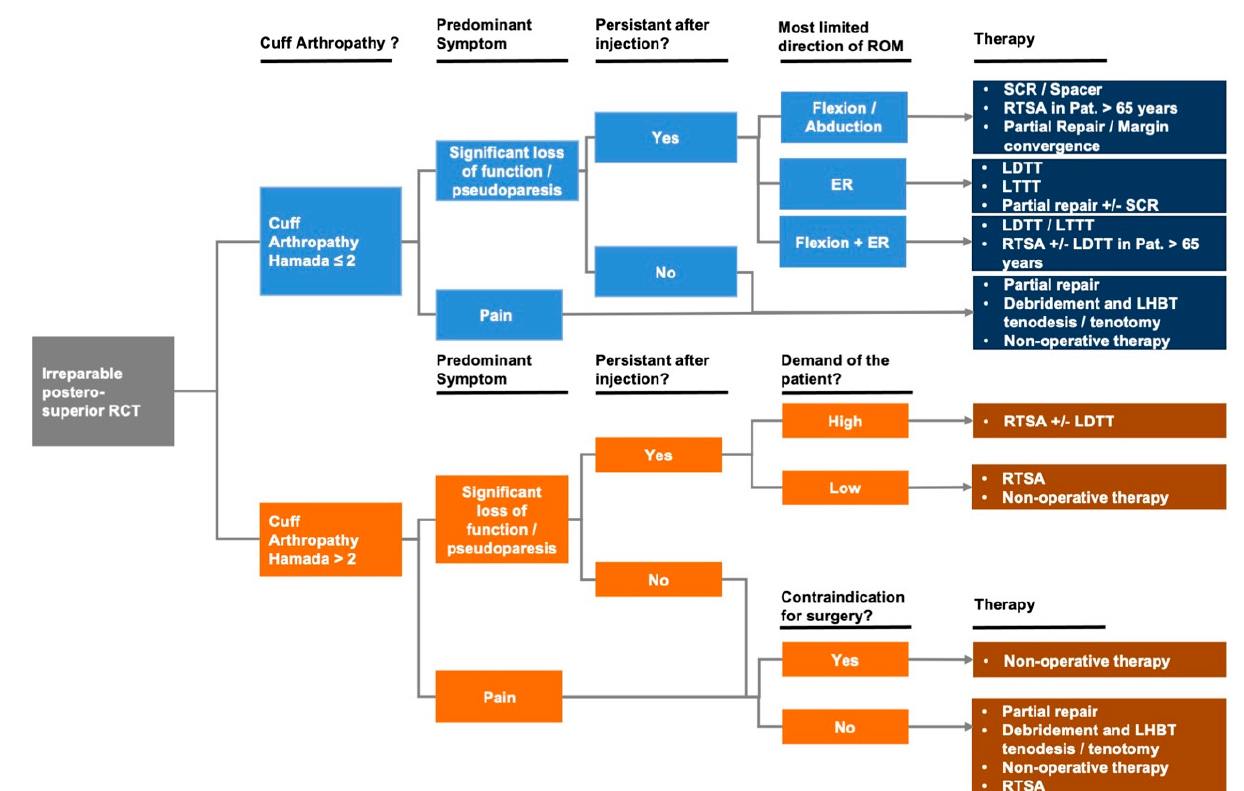
Figure 1. Treatment algorithm in the setting of irreparable posterosuperior rotator cuff tears. Abbreviations: ER, external rotation; SCR, superior capsule reconstruction; ROM, range of motion; RTSA, reverse total shoulder arthroplasty; LDTT, latissimus dorsi tendon transfer; LTTT, lower trapezius tendon transfer; LHBT, long head of the biceps tendon.